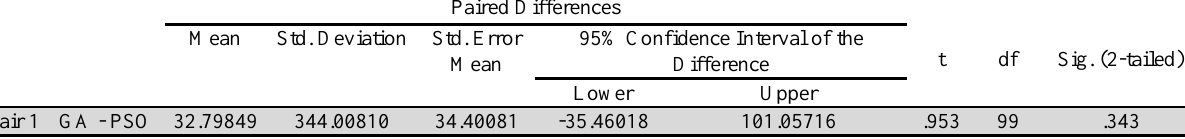
The summary of t-student test between GA and PSO for 10 assets based on the measure of LPM Paired Differences Mean Std.